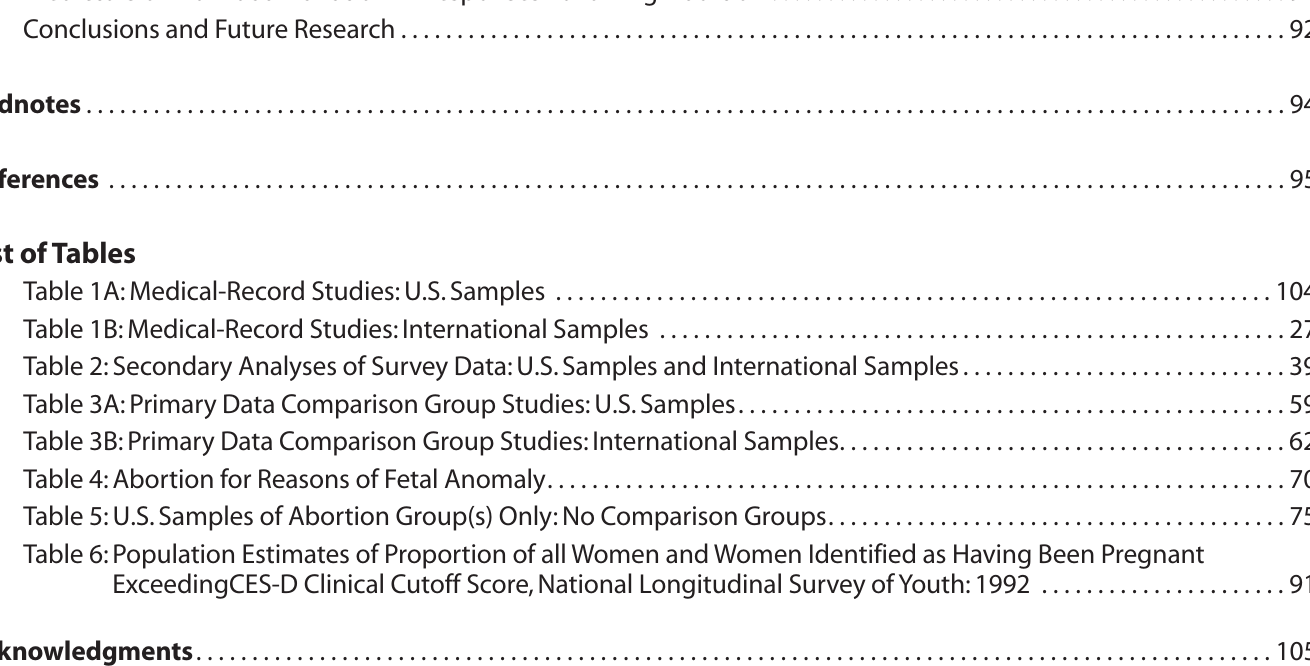
Table 6:Population Estimates of Proportion of all Women and Women Identified as Having Been